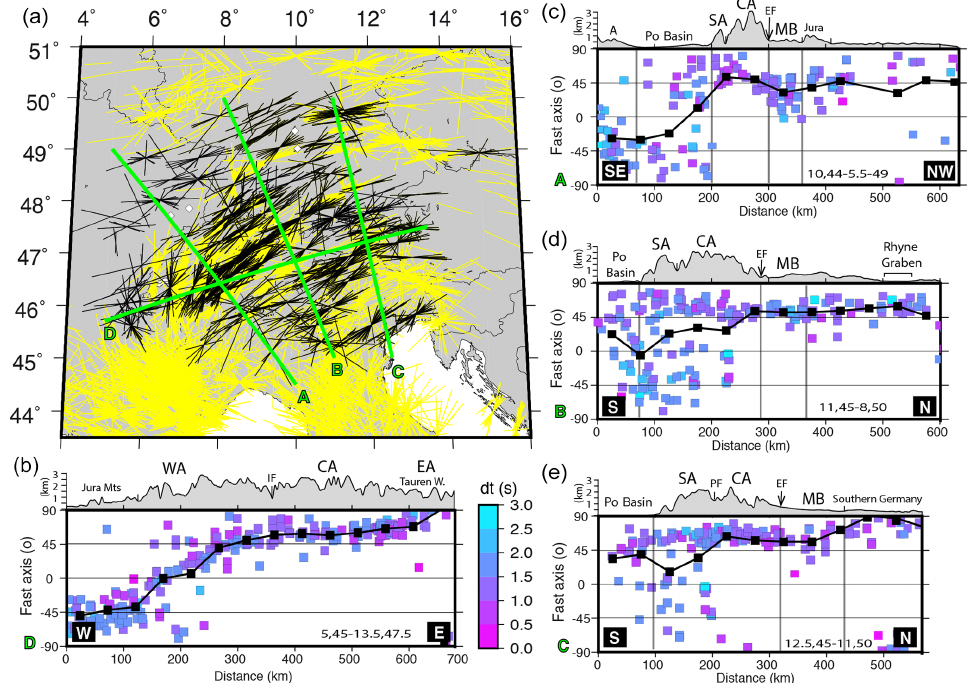
Figure 5. Sections of SKS splitting parameters across and along the Alpine orogen. (a) Map of western and central Europe showing past SKS results (yellow lines) and observations from this study (black lines). The green lines mark the locations of chosen sections. (b–e) Sections across and nearly along the orogen showing single-station SKS fast-axis direction variation within ± 50km distance from the section. On top of each section, topography and the location of major geological units are reported: SA (Southern Alps), CA (Central Alps), WA (Western Alps), PF (Periadriatic Fault), IF (Insubric Fault), and AF (Alpine Front). Black squares are average ϕ direction along the profile in 50km distance